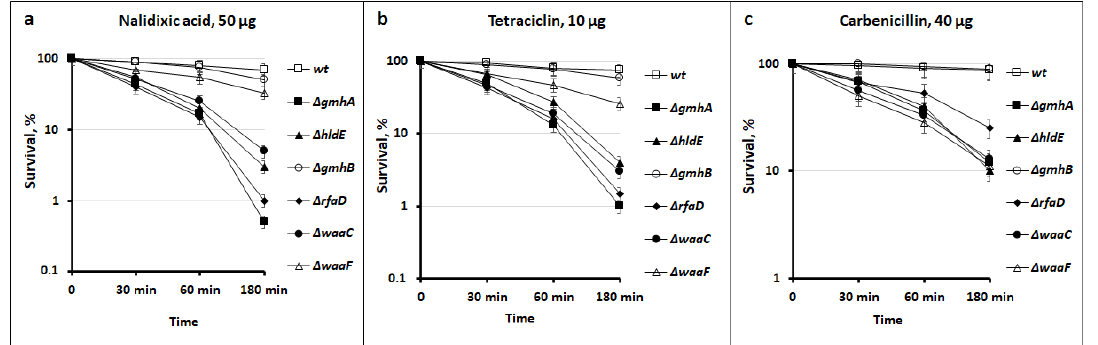
Figure 4. Survival of E. coli MG1655 strains containing knockouts for ADP-heptose activation genes ( gmhA , hldE , gmhB , rfaD , waaC , and waaF ). Representative curves show the effect of deficiency ADP-heptose biosynthesis on antibiotic-mediated killing. Mean values ± SD from at least three independent experiments are shown.